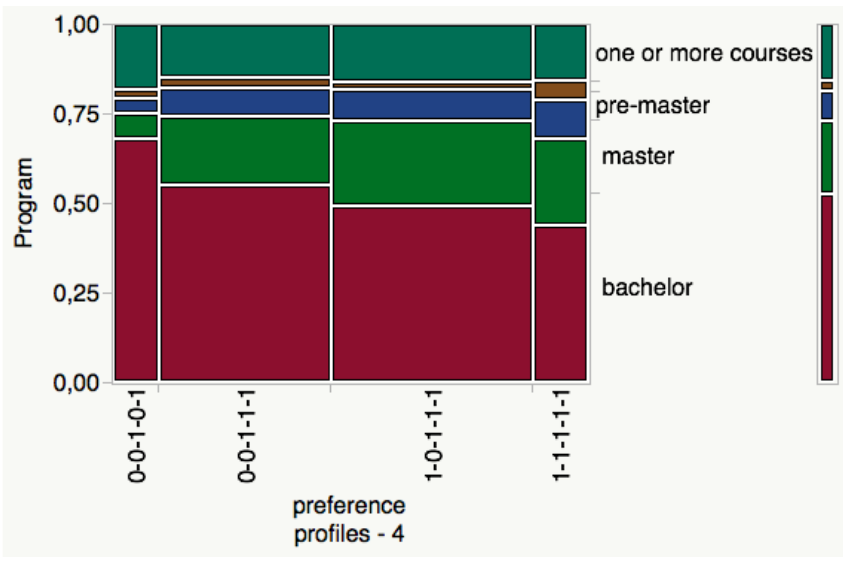
Figure 2. Association of preference profiles with type of program for enrolled students.